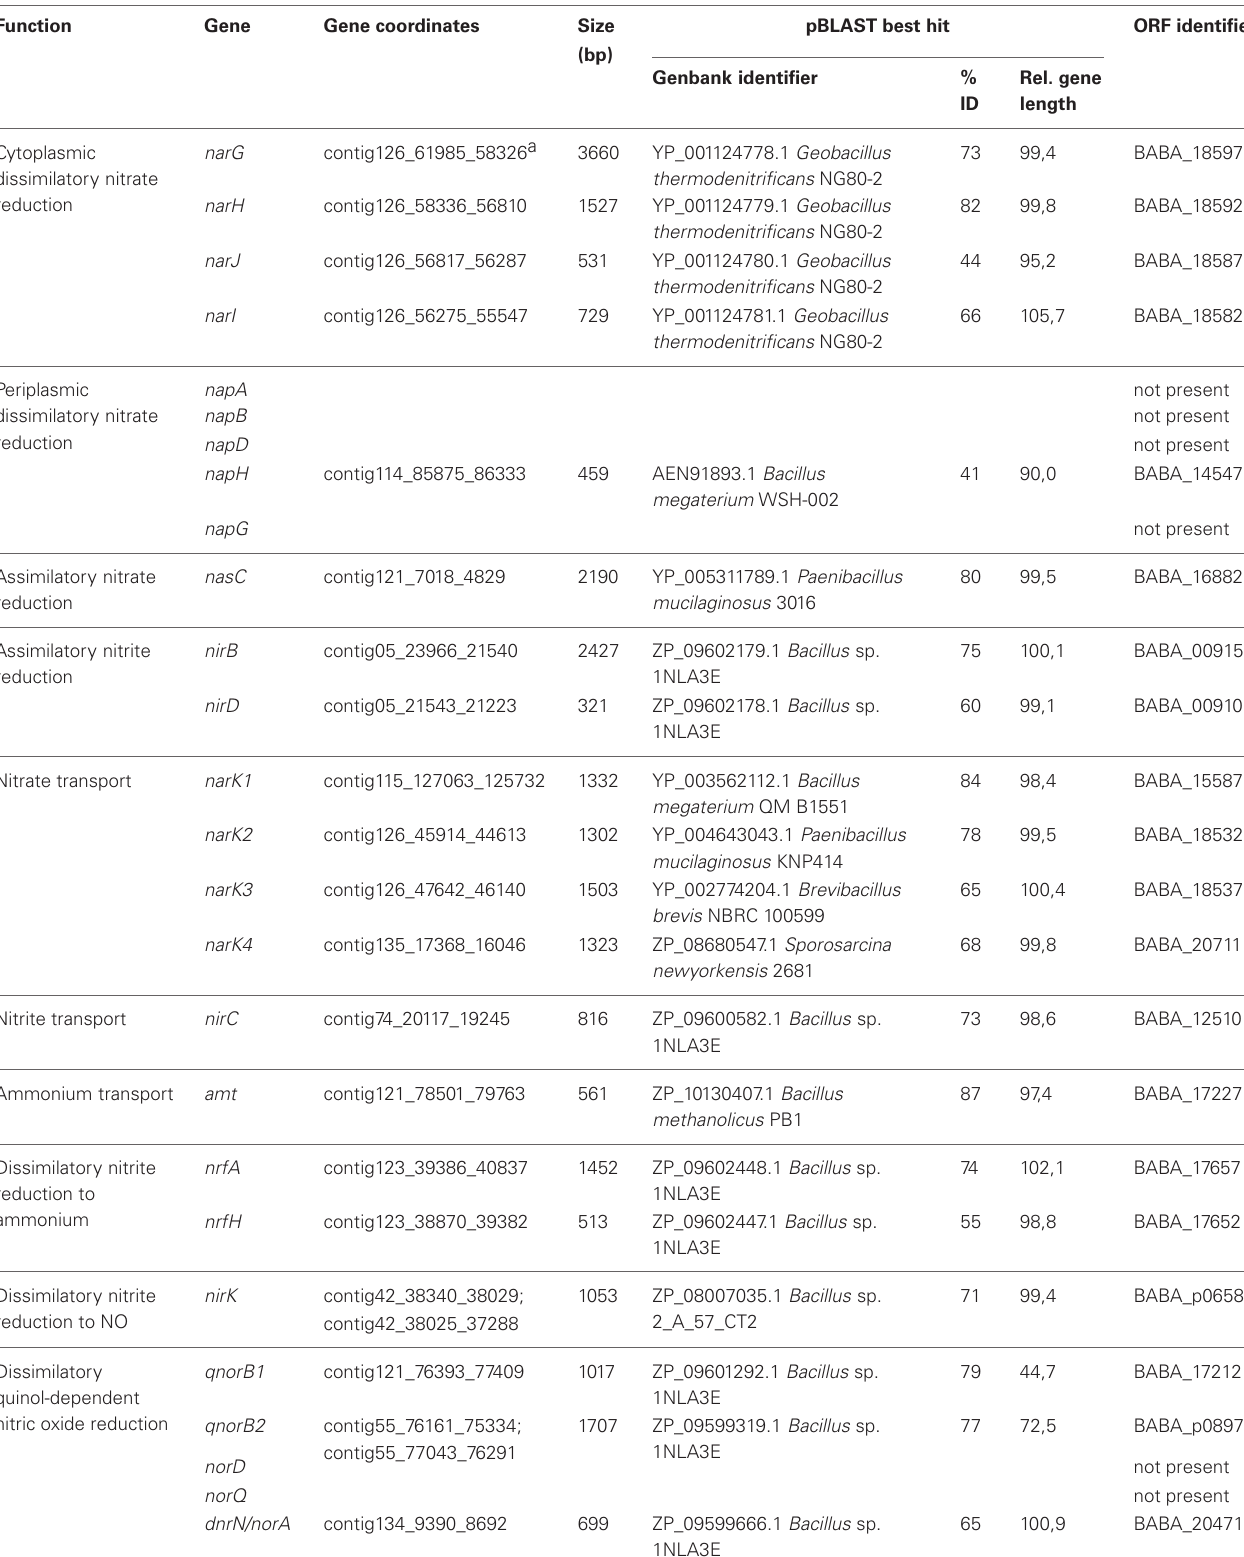
Table 3 | Overview of gene inventory involved in nitrogen assimilation, denitrification and ammonification of B. bataviensis LMG 21833 T .